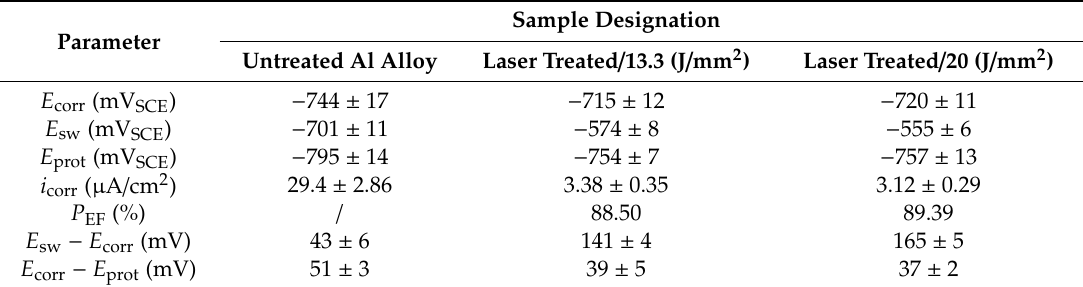
Table 1. Electrochemical parameters obtained from the CP curves in 0.5 M NaCl solution.